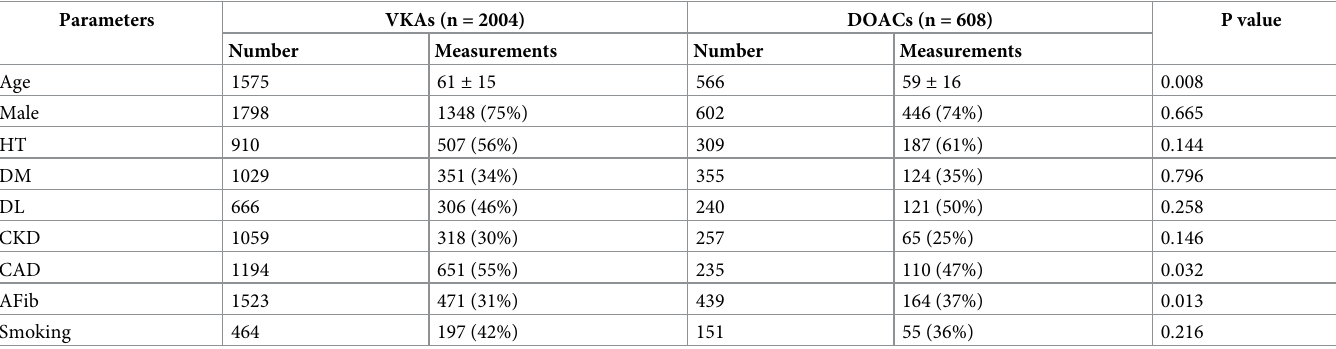
Left ventricular thrombus resolution Among the 23 articles, 17 reported LV thrombus resolution , including 15 in the VKA treatment group and 12 in the DOAC group. Fig 2 shows forest plots of the thrombus resolution rate with VKAs and DOACs. The pooled analysis presented a similar rate and 95% CI of LV thrombus Table 1. Comparison of clinical characteristics between treatment